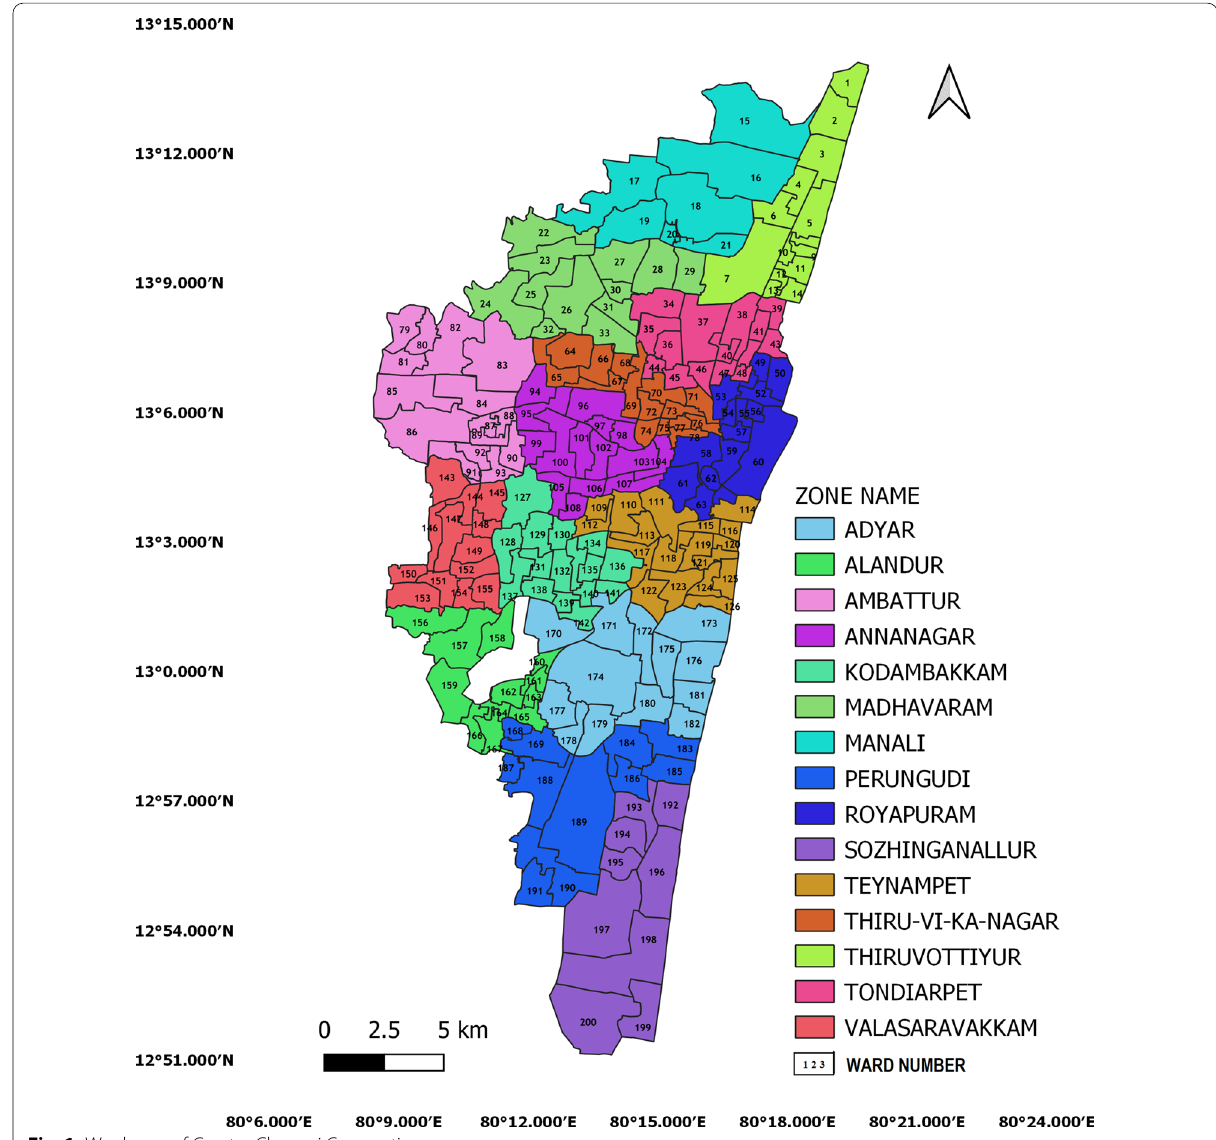
Fig. 1 Ward map of Greater Chennai